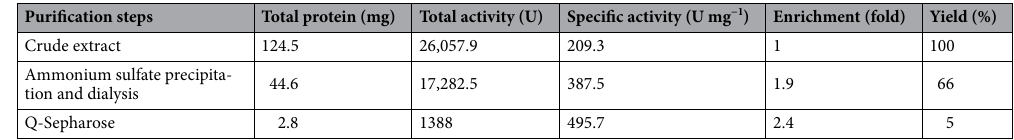
Table 1. Purification scheme of the CapA.